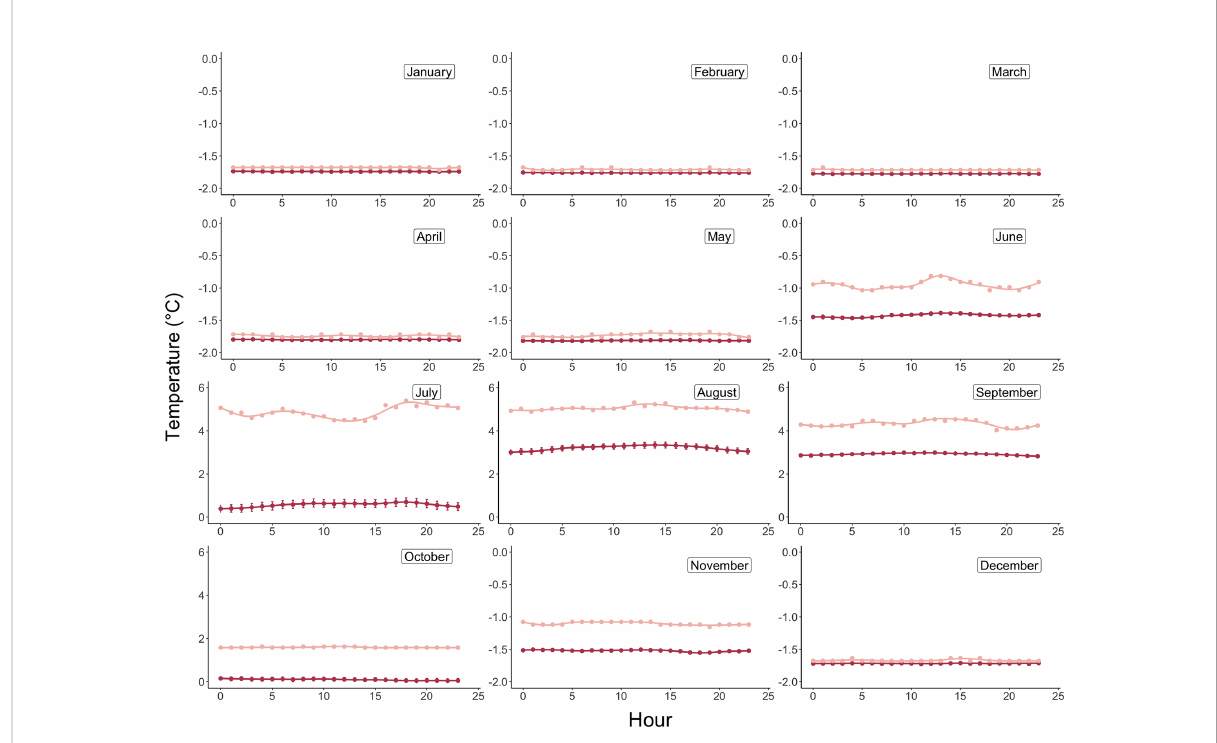
FIGURE 4 Daily average (maroon) and maximum (pink) temperature pro fi les by month at 15m depth in Arctic Bay, Nunavut, Canada across the experimental period. Note differences in y-axis scales.